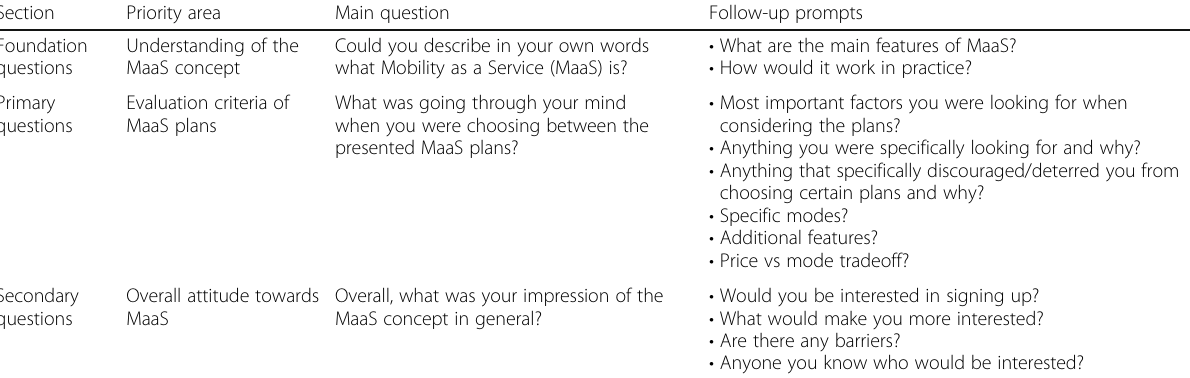
Table 1 Semi-structured questions and prompts used in interview